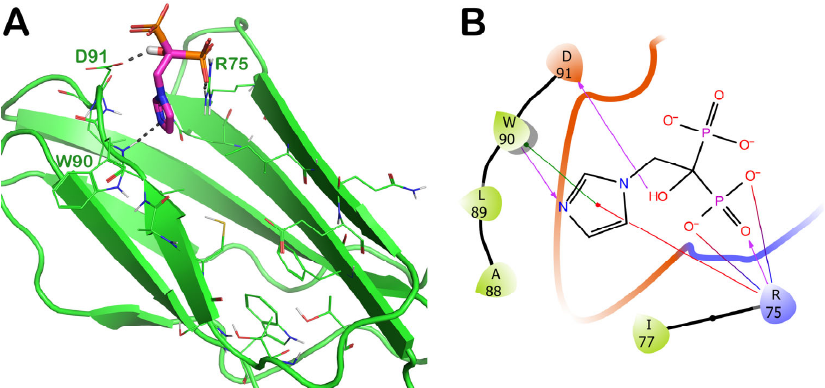
Figure 7. ( A ) Docking output of compound ZINC000003803652 (magenta sticks) within the surface of the irisin monomer (PDB ID 4LSD, green cartoon) involved in the dimerization process. The key interacting residues are represented by lines. The H bonds are depicted as dotted lines. Non-polar hydrogen atoms were removed for the sake of clarity. ( B ) A 2D representation of the contacts established by ZINC000003803652 within the irisin monomer interface. Images were prepared using PyMOL and the Ligand-Interaction Diagram application implemented in